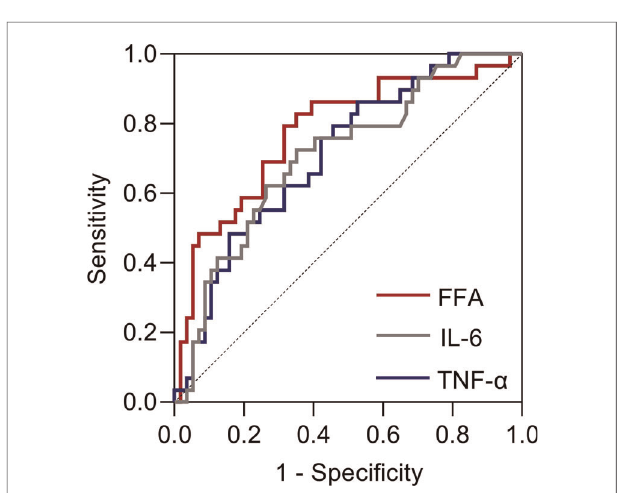
FIGURE 4 | Receiver operating characteristic (ROC) curves for poor glycaemic control after taking